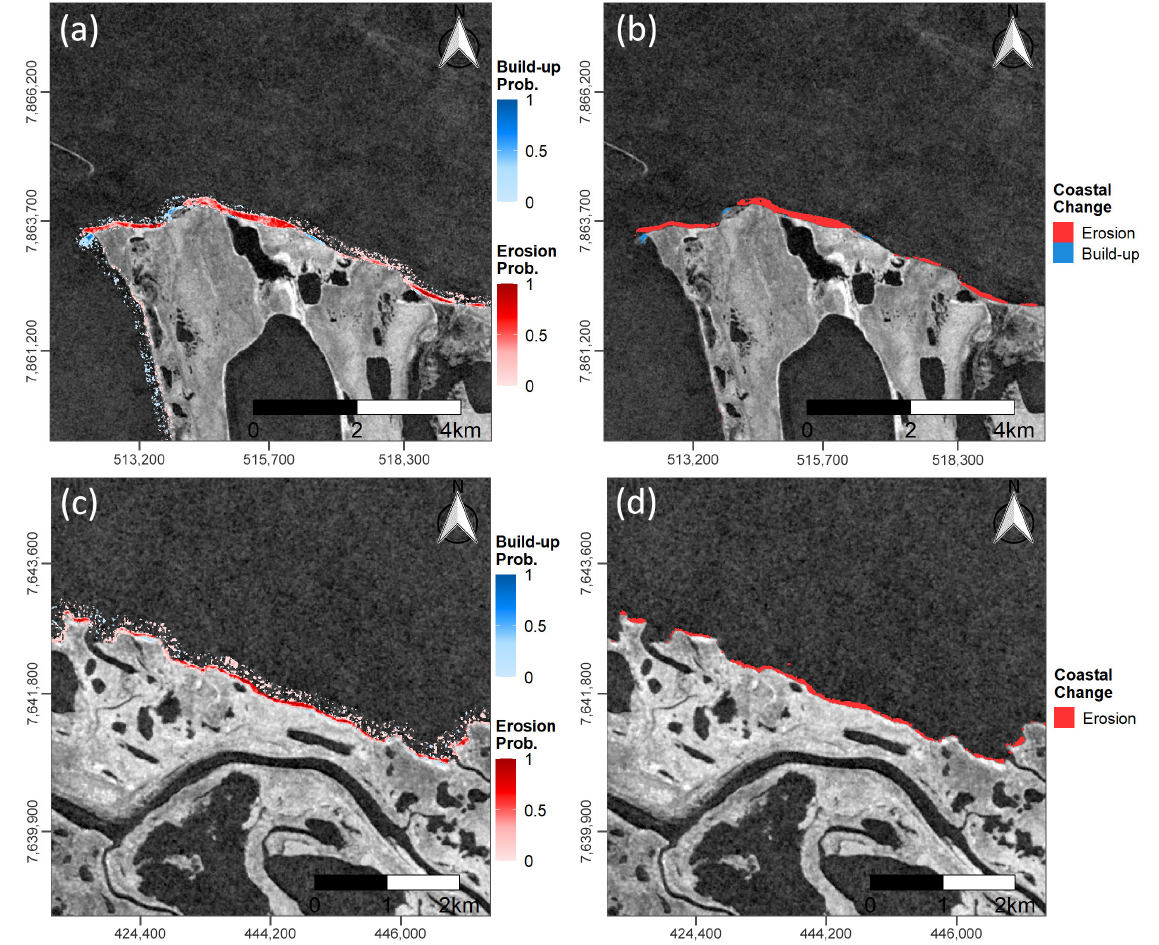
Figure 10. Probability maps of erosion and build-up rates between 2017 and 2020 for subsets of Cape Halkett, USA (aoi 02) ( a ), and Shoalwater Bay, Canada (aoi 03) ( c ), together with their respective maps of coastal change ( b,d ). A threshold of 0.35 for the erosion and 0.6 for the build-up was applied ( b,d ). The CVA-based coastal change analysis revealed maximum erosion rates of up to 160.3 m and an average rate of 4.4 m across the total investigated area over three years between 2017 and 2020. Maximum build-up rates of 166.7 m and an average build-up rate of 1.9 m could be observed across all aois, respectively. The numbers hereby refer to the average rates of change for 200 m segments along the coastline. The strongest erosion was detected for Drew Point–Cape Halkett in the USA (max: 160.3 m; average: 22 m), followed by Shoalwater Bay in Canada (max: 70 m; average: 10.3 m). On the other hand, the highest build-up numbers were observed for Bezimyanniy Cape–Eastern Oyagoss Cape in Russia (max: 166.7 m; average: 8.7 m), followed by Sims Bay, Russia (max: 58 m; average 1.4